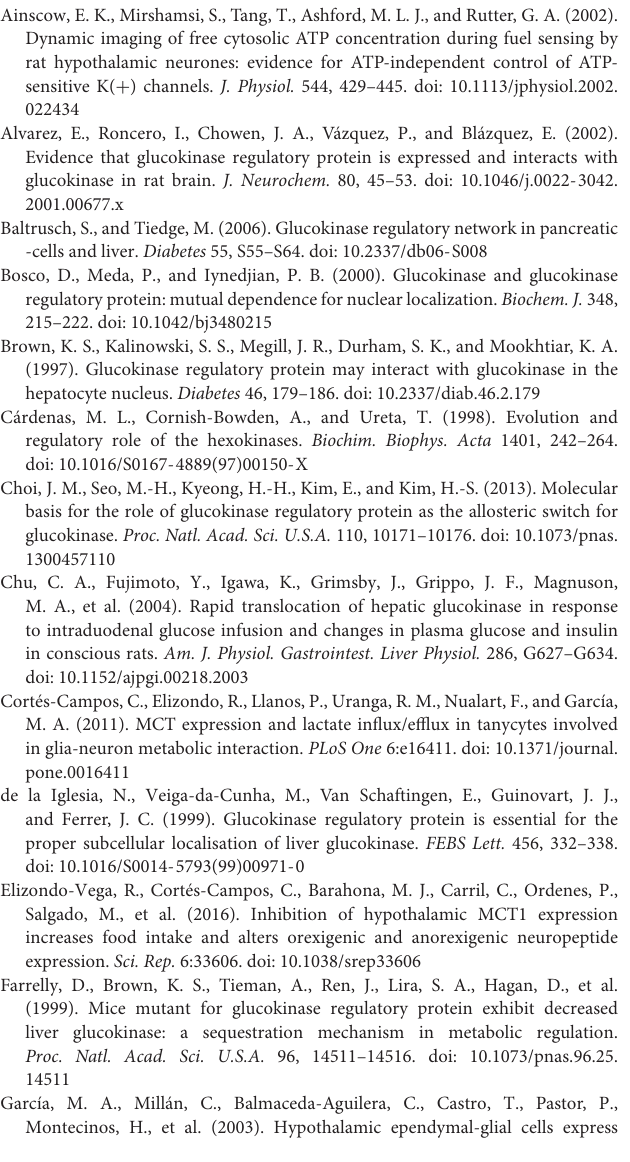
the glucose transporter GLUT2, a protein involved in glucose sensing. J. Neurochem. 86, 709–724. doi: